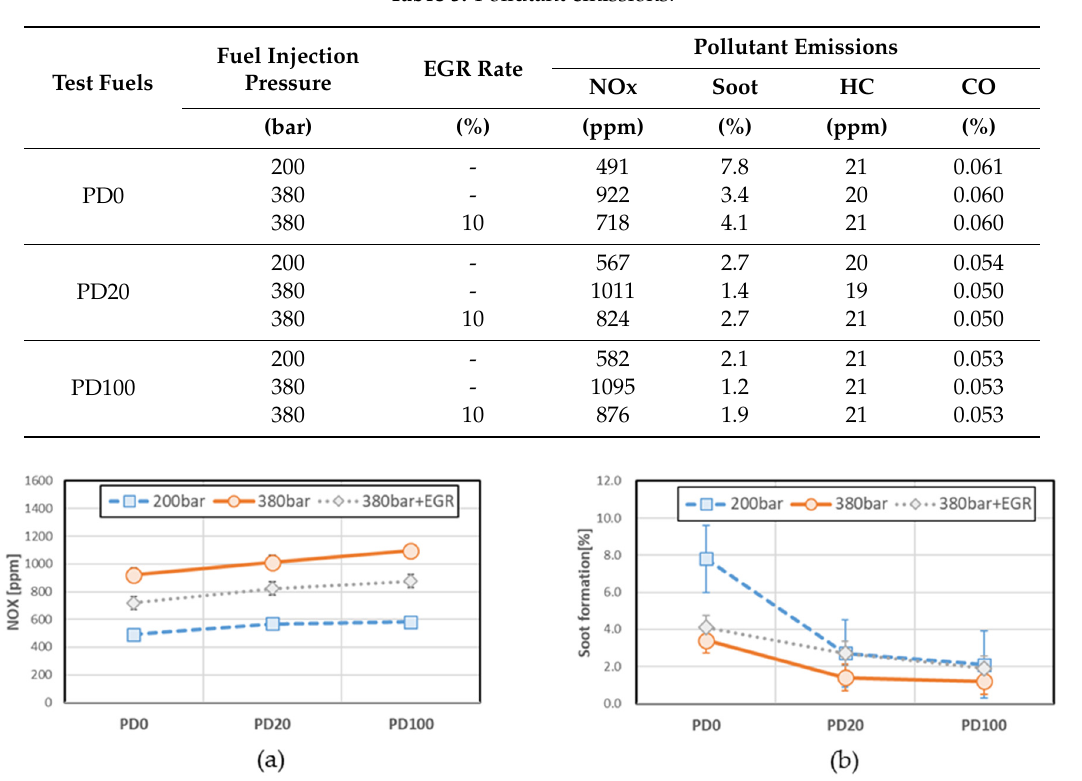
Figure 8. NOx and PM. ( a ) NOx and ( b ) smoke opacity by PM.